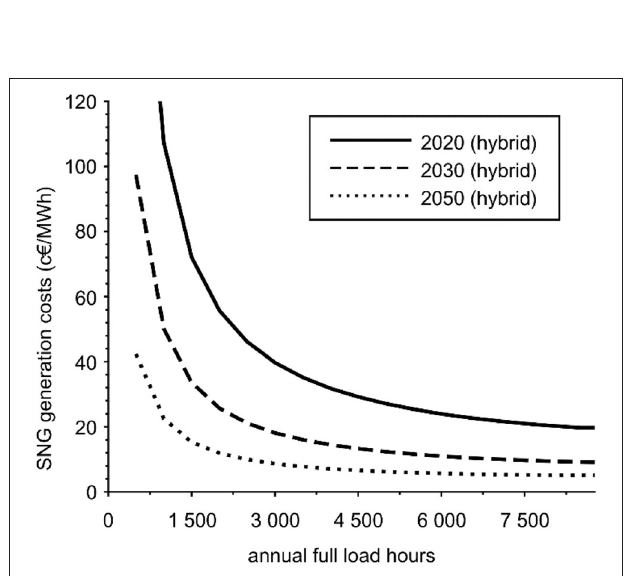
FIGURE 8 | SNG generation costs in dependence of annual FLH of operation for the 5 MW reference